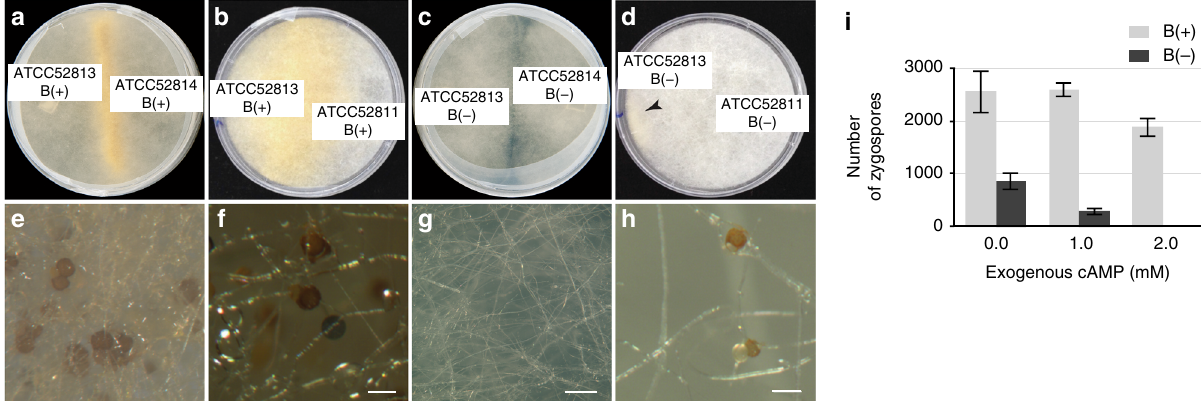
Fig. 1 Impact of Burkholderia endobacteria on the reproductive biology of the Rm host. Successful mating between sex-compatible Rm B(+) strains: a ATCC 52813 and ATCC 52814, and b ATCC 52813 and ATCC 52811. c Complete loss of mating between B( − ) isolates ATCC 52813 and ATCC 52814. d Restricted mating between B( − ) isolates ATCC 52813 and ATCC 52811, with zygospores formed in the area indicated by an arrow. Accumulation of zygospores and β - carotene in the zone of interaction between B(+) mates: e ATCC 52813 and ATCC 52814, scale bar 100 μ m, and f ATCC 52813 and ATCC 52811, scale bar 100 μ m. g No sexual structures or β -carotene are apparent in the zone of interaction between B( − ) mates ATCC 52813 and ATCC 52814 that show total loss of mating; scale bar 500 μ m. h Rare zygospores produced during an interaction between B( − ) mates ATCC 52813 and ATCC 52811 that resulted in restricted mating; scale bar 100 μ m. i Effects of endobacteria and exogenous dibutyryl cAMP on the formation of zygospores during mating between B(+) ATCC 52813 and ATCC 52814 vs. mating between B( − ) ATCC 52813 and ATCC 52814 showing limited zygospore formation. Increased concentrations of cAMP reduced the rate of zygospore formation in the interactions between B( − ) mates that were capable of restricted mating (Student post hoc test of the interaction between bacterial presence and cAMP level in two-way ANOVA, P = 0.02), whereas the decrease in zygospore formation in interactions between B(+) mates was not statistically signi fi cant. Ten mating interactions were examined per condition. B(+), endobacteria present; B( − ), endobacteria absent; error bars represent